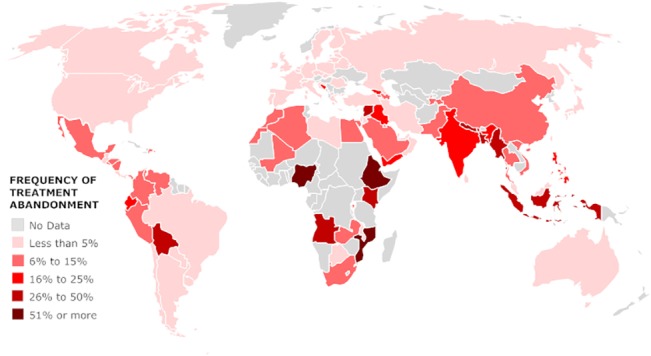
Reported median frequency of treatment abandonment (TxA) by country.